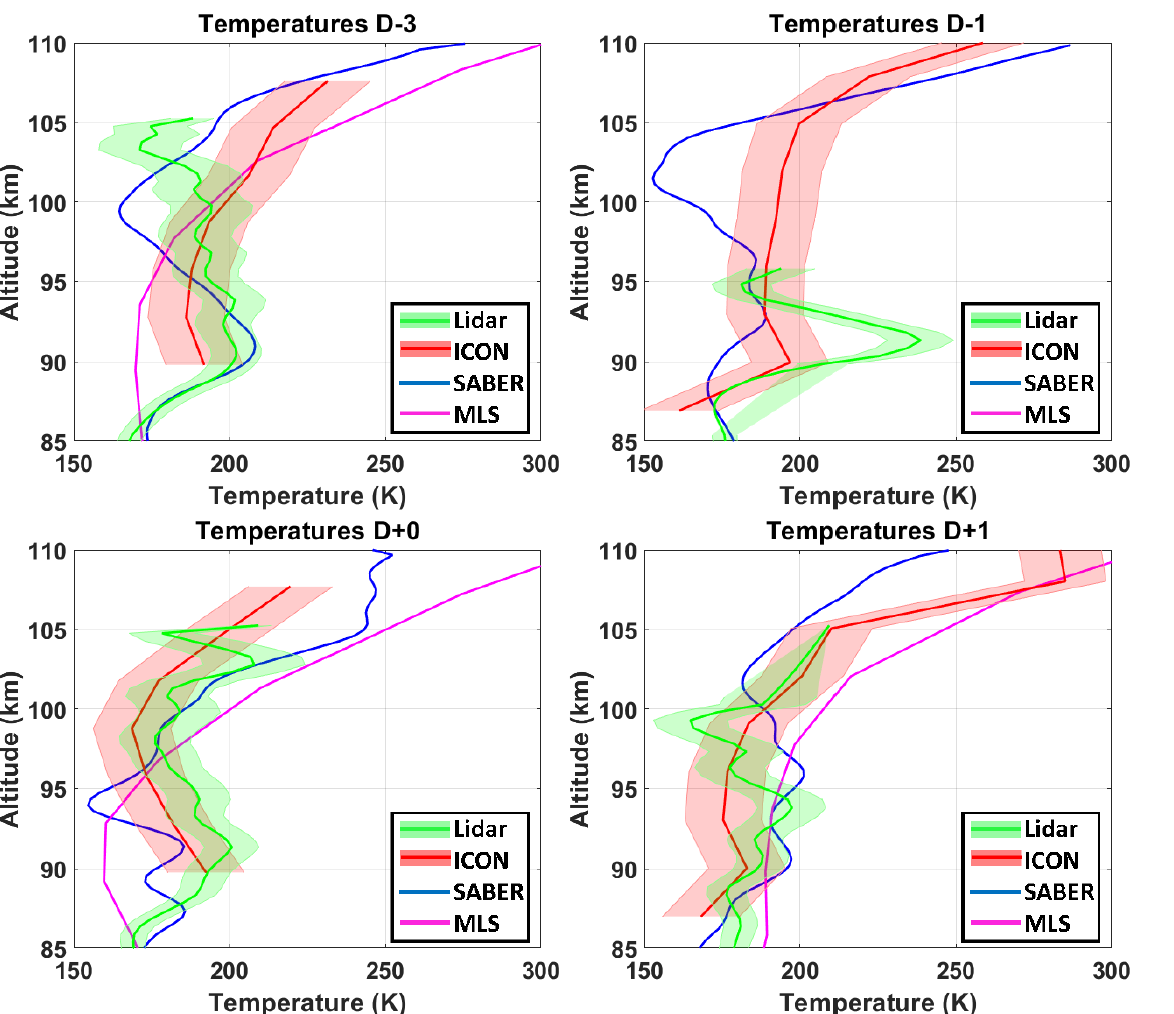
Figure 6. Nightly average temperature profiles created by Monge lidar (green), ICON (red), SABER (blue), and MLS (magenta) covering only the